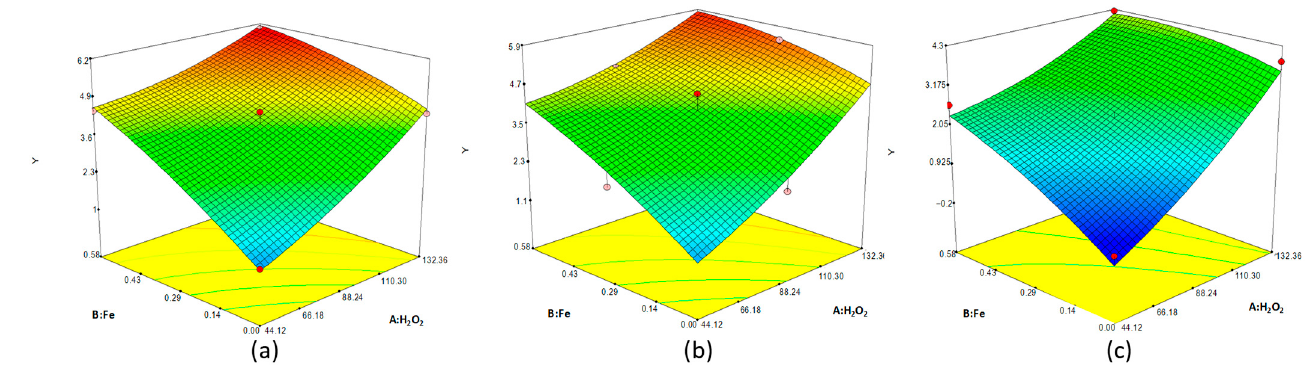
Figure 1. 3D response surface of FP showing the reduction colonies (Y) at 15 min in function of the initial concentration of H 2 O 2 (mM) and Fe +2 (mM) at different pHs: ( a ) 3, ( b ) 5 and ( c ) 7.